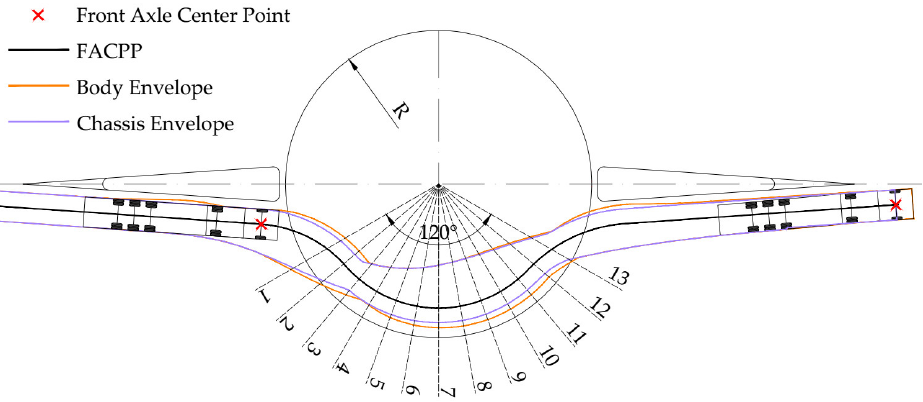
Figure 5. Cross-sections and investigated envelopes and paths.